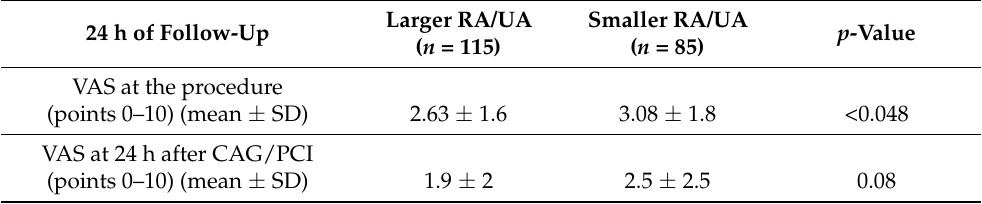
Table 3. Outcomes of visual analog scale (VAS) for pain at the procedure and after 24 h. Larger RA/UA Smaller RA/UA p -Value 24 h of Follow-Up ( n = 115) ( n = 85) VAS at the procedure (points 0–10) (mean ± SD) 2.63 ± 1.6 3.08 ± 1.8 <0.048 VAS at 24 h after CAG/PCI (points 0–10) (mean ± SD) 1.9 ± 2 2.5 ± 2.5